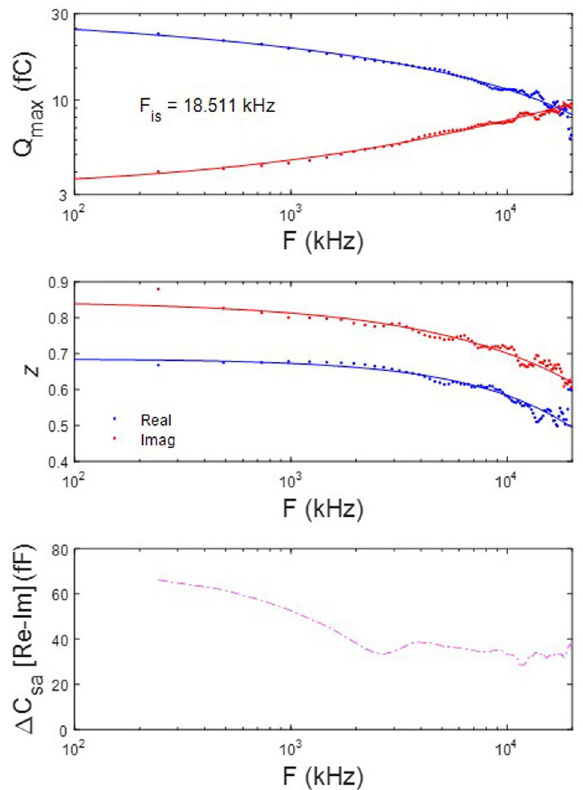
Figure 2. Frequency dependence of complex NLC components. Top panel Plot of fitted Q max of 2-state components of complex NLC. The real and imaginary component magnitudes intersect at a particular frequency, F is . Here the imaginary component absolute magnitude is plotted. Fits (solid lines) are with Eq. (2). Red is real component; blue is imaginary component. F is is 18.5 kHz. Middle panel Plot of the Boltzmann parameter, z . Both decrease in parallel with frequency, with the imaginary component being smaller, indicating a shallower voltage sensitivity. Bottom panel Plot of difference between real and imaginary ΔC sa , showing some low frequency dependence. Figure 1A,B indicate that ΔC sa is largely absent in the imaginary